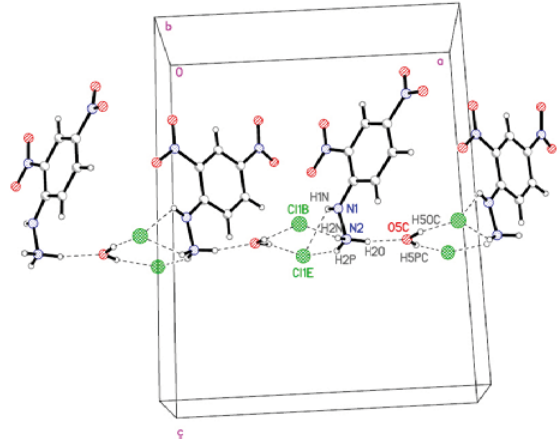
Figure 3. A part of molecular packing showing sixth-level 3 graph (D motif intermolecular hydrogen bonds are indi- cated by dashed lines). Symmetry transformations used to generate equivalent atoms: Cl1E x-1/2,-y+1,z; Cl1B